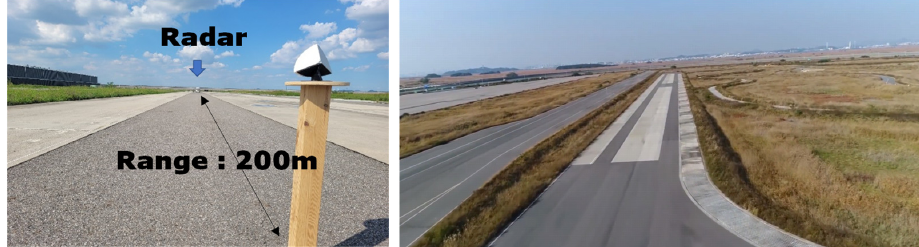
Figure 17. Test site view.